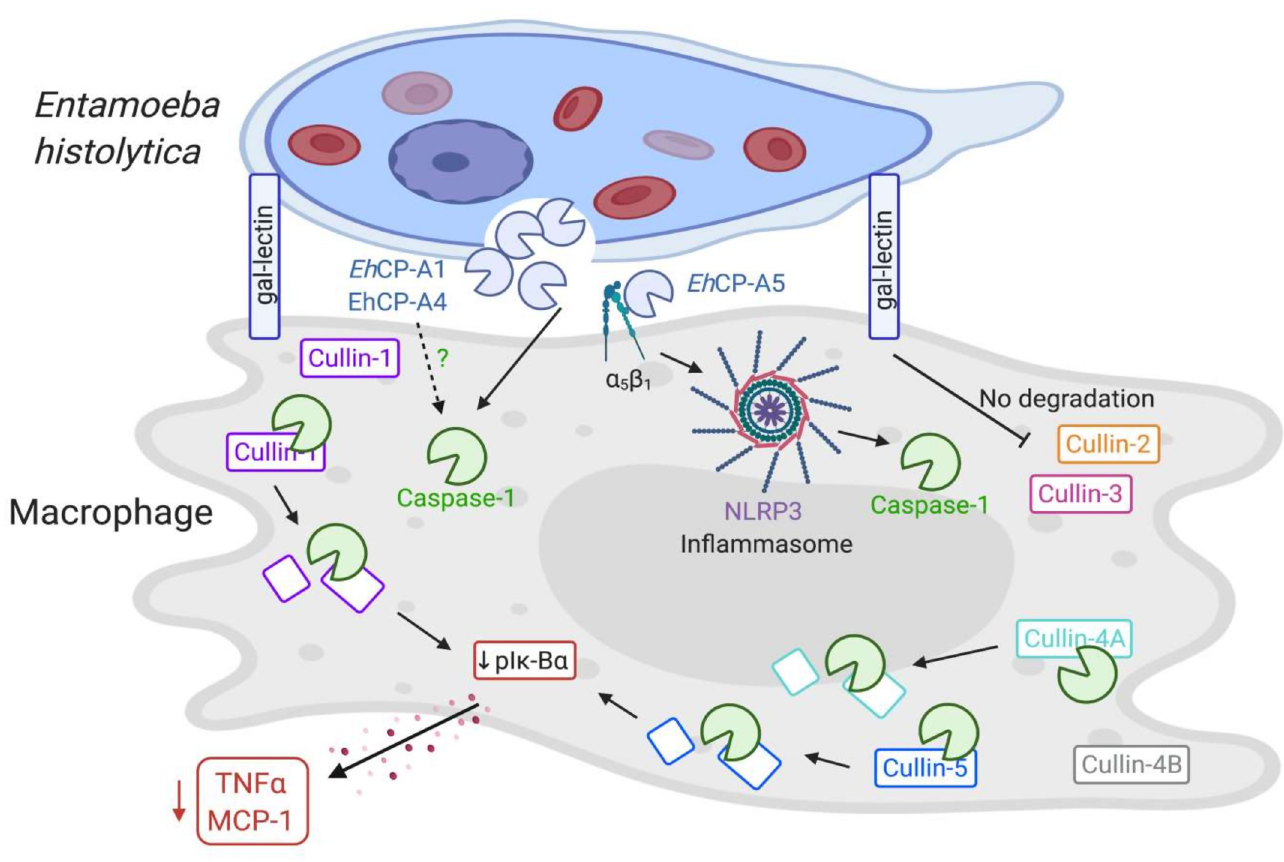
Fig 8. Proposed model of the study. Eh Gal-lectin initiates contact with macrophages allowing surface bound Eh CP-A5 and vesicle bound cysteine proteinases, Eh CP-A1 and Eh CP-A4 to interact with macrophage membranes at the intercellular junction. Eh CP-A1 and Eh CP-A4 degradation of cytoskeletal proteins trigger the NLRP3 inflammasome to activate caspase-1 through an unknown mechanism that subsequently degrades cullin-1/5, that in turn decreased the phosphorylation of I κ -B α inhibiting the transcription and secretion of NF- κ B dependent pro-inflammatory cytokines. Eh -macrophage interaction also led to the degradation of cullin-4A which was partially dependent on caspase-1 but independent in the degradation of cullin-4B. Cullin-2/3 were not degraded in response to Eh